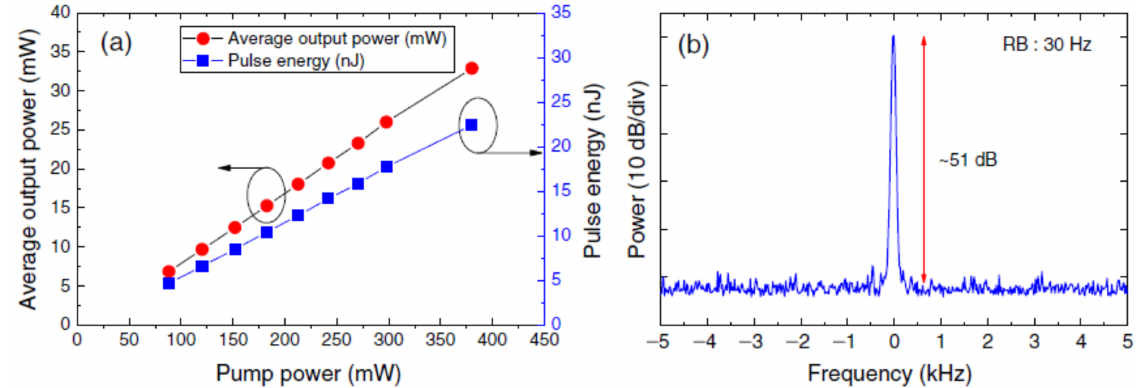
Figure 17. ( a ) Average output power and pulse energy measurements as a function of the pump power. ( b ) Measured electrical spectrum of the output pulses. Reprinted with permission from